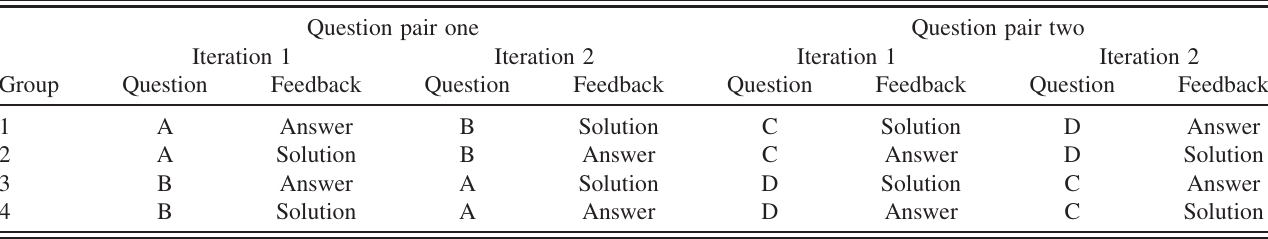
TABLE I. Order in which problems are seen by four different groups, as well as their access to answers and solutions after answering the question. Four groups of students are required in order to capture students’ performance on every problem for all three situations (first of the pair, after its pair with the answer and after its pair with the solution option). Problem A, B, C and D in the table are used to emphasis that all four groups should receive the same amount of answer or solution treatment.